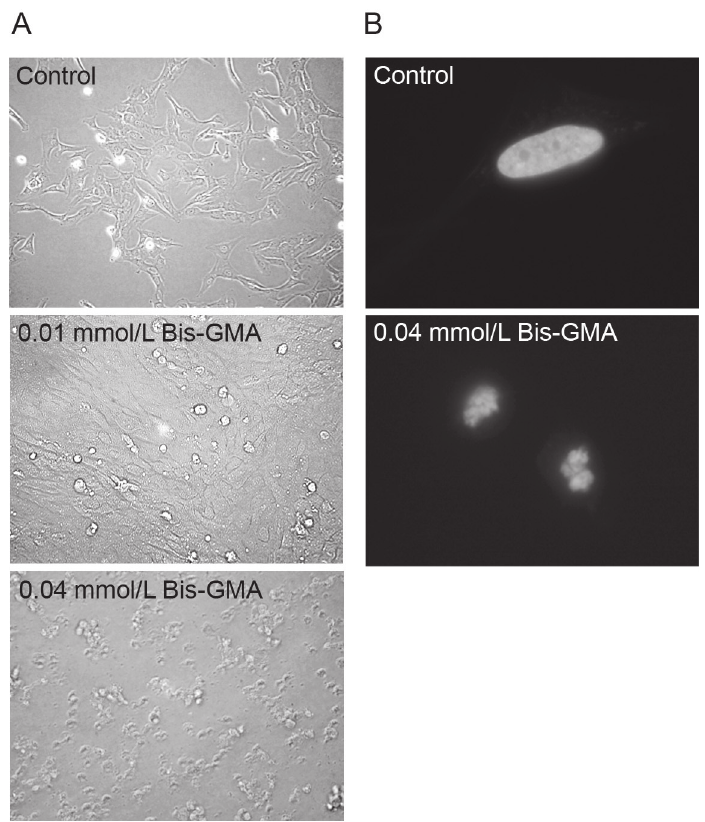
Figue 2- Morphological changes of LSC2 cells promoted by 2, 2-bis [4-(2-hydroxy-3-methacryloxypropoxy) phenyl] propane (Bis-GMA). (A). Phase-contrast microphotographs of LSC2 cells after exposure to Bis-GMA. Original magnification, x100. (B). Fluorescent microphotographs of LSC2 cells after exposure to Bis-GMA. Original magnification,